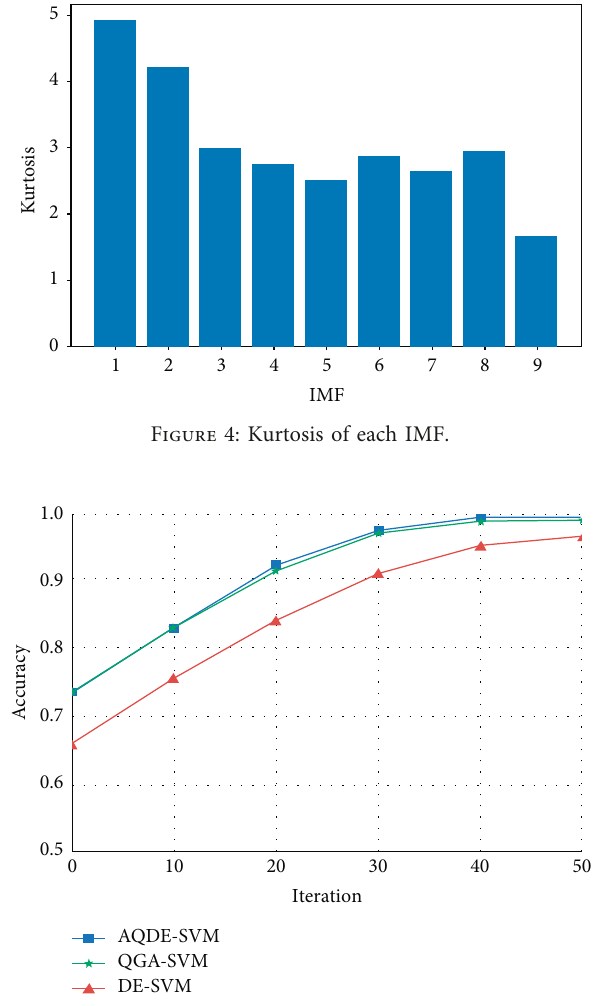
Figure 5: Fault diagnosis accuracy curve. Table 3: Comparison results of fault